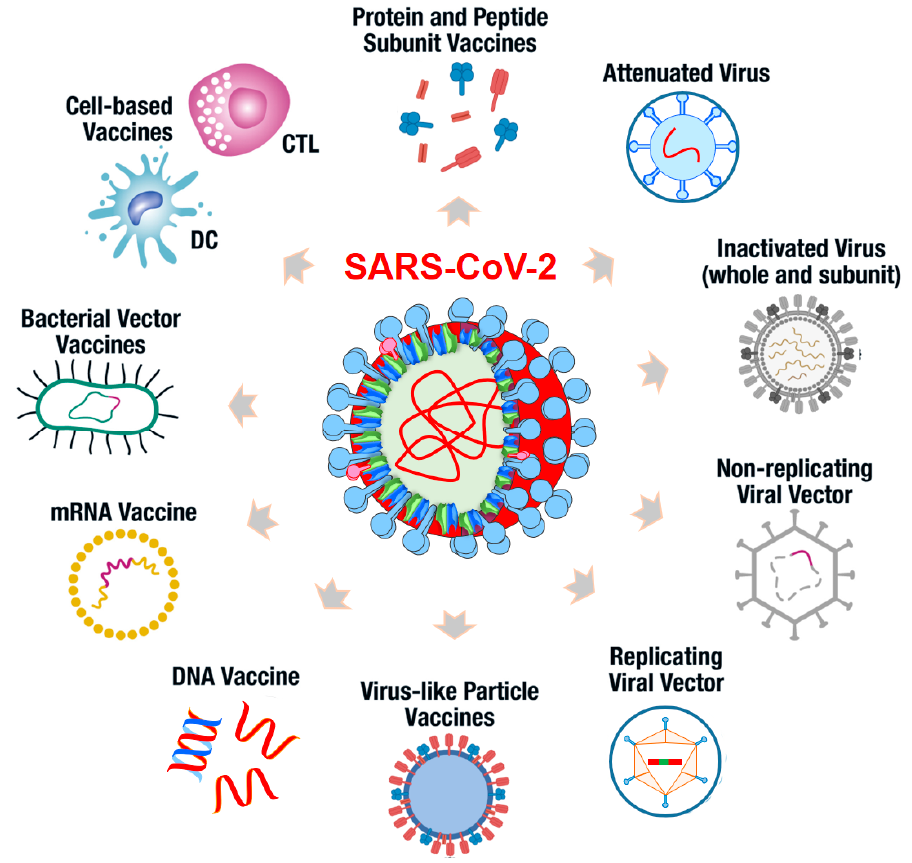
Figure 4. Vaccine platforms used for SARS-CoV-2 vaccine development. Table 2. SARS-CoV-2 vaccine platforms.